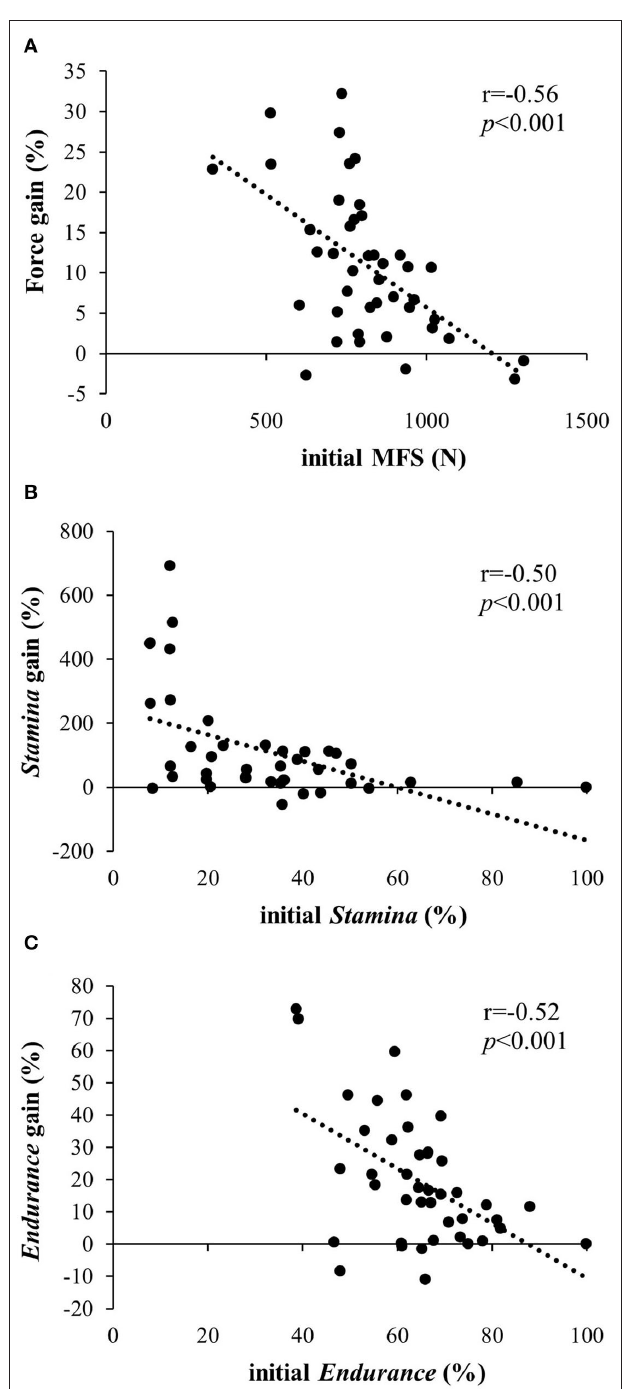
FIGURE 4 | Post-training gain (in %) according to the initial (A) MFS (in N), (B) stamina (in %), and (C) endurance (in %) for training group subjects (F60, F80, and F100).